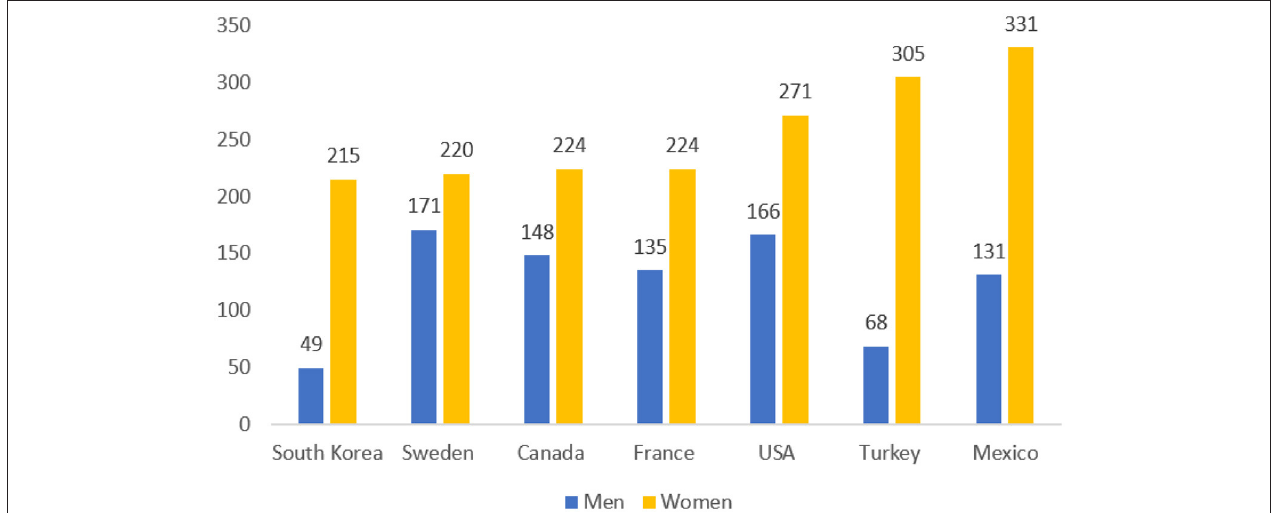
FIGURE 1 | Average unpaid work (minutes) by gender in major countries (Source: Statistics